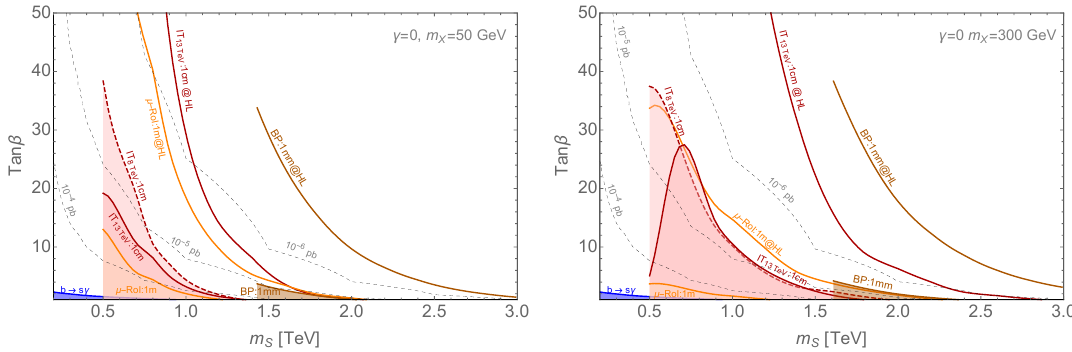
Figure 5 . Parameter space of the doublet Higgs scenario as a function of m S and tan (cid:12) overlaid with current and projected constraints from direct searches. For the plot, we assume the alignment limit (cid:13) = 0, the branching ratio into invisible equal to 0 and equal branching ratios into displaced objects and visible (cid:12)nal states (mainly t (cid:22) t ). On the left/right panel we show results for m X = 50 GeV =m X = 300 GeV. The shaded regions and solid lines are as in (cid:12)gure 4. Gray contours represent the rate for t (cid:22) tS; S ! XX (2 displaced). The blue shaded region on the bottom left of the plots is the region probed by the measurement of b ! s(cid:13) , under the assumption m S = m Higgses do not couple directly to Standard Model vectors, leaving only gluon fusion and t (cid:22) tS associated production as the dominant production modes, and the challenging S ! t (cid:22) t decay as the primary prompt decay mode (for the prospects for this decay mode see